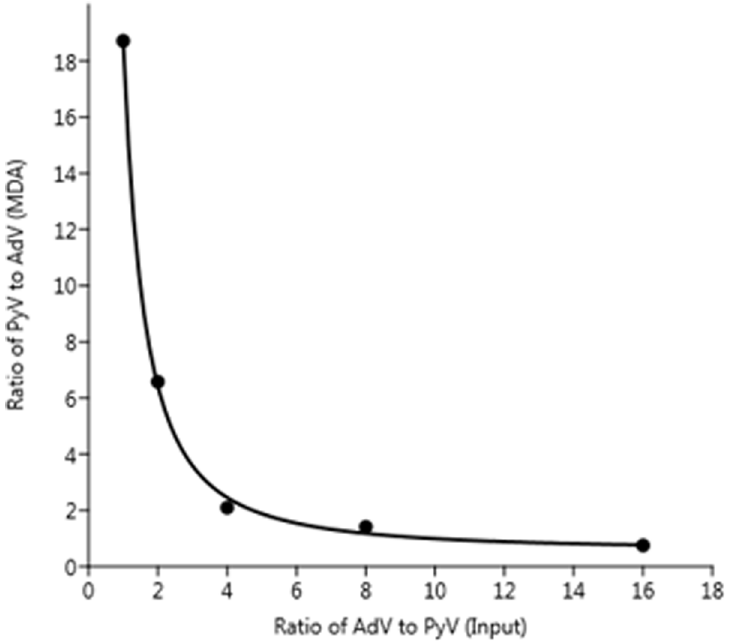
Fig 4. Comparison of normalized input DNA and MDA product ratios. Nonlinear regression of an exponential decay curve was performed using Eq 2, where a = 55.9, b = -1.16 and c = 1.21. The Akaike information criteria (AIC) was